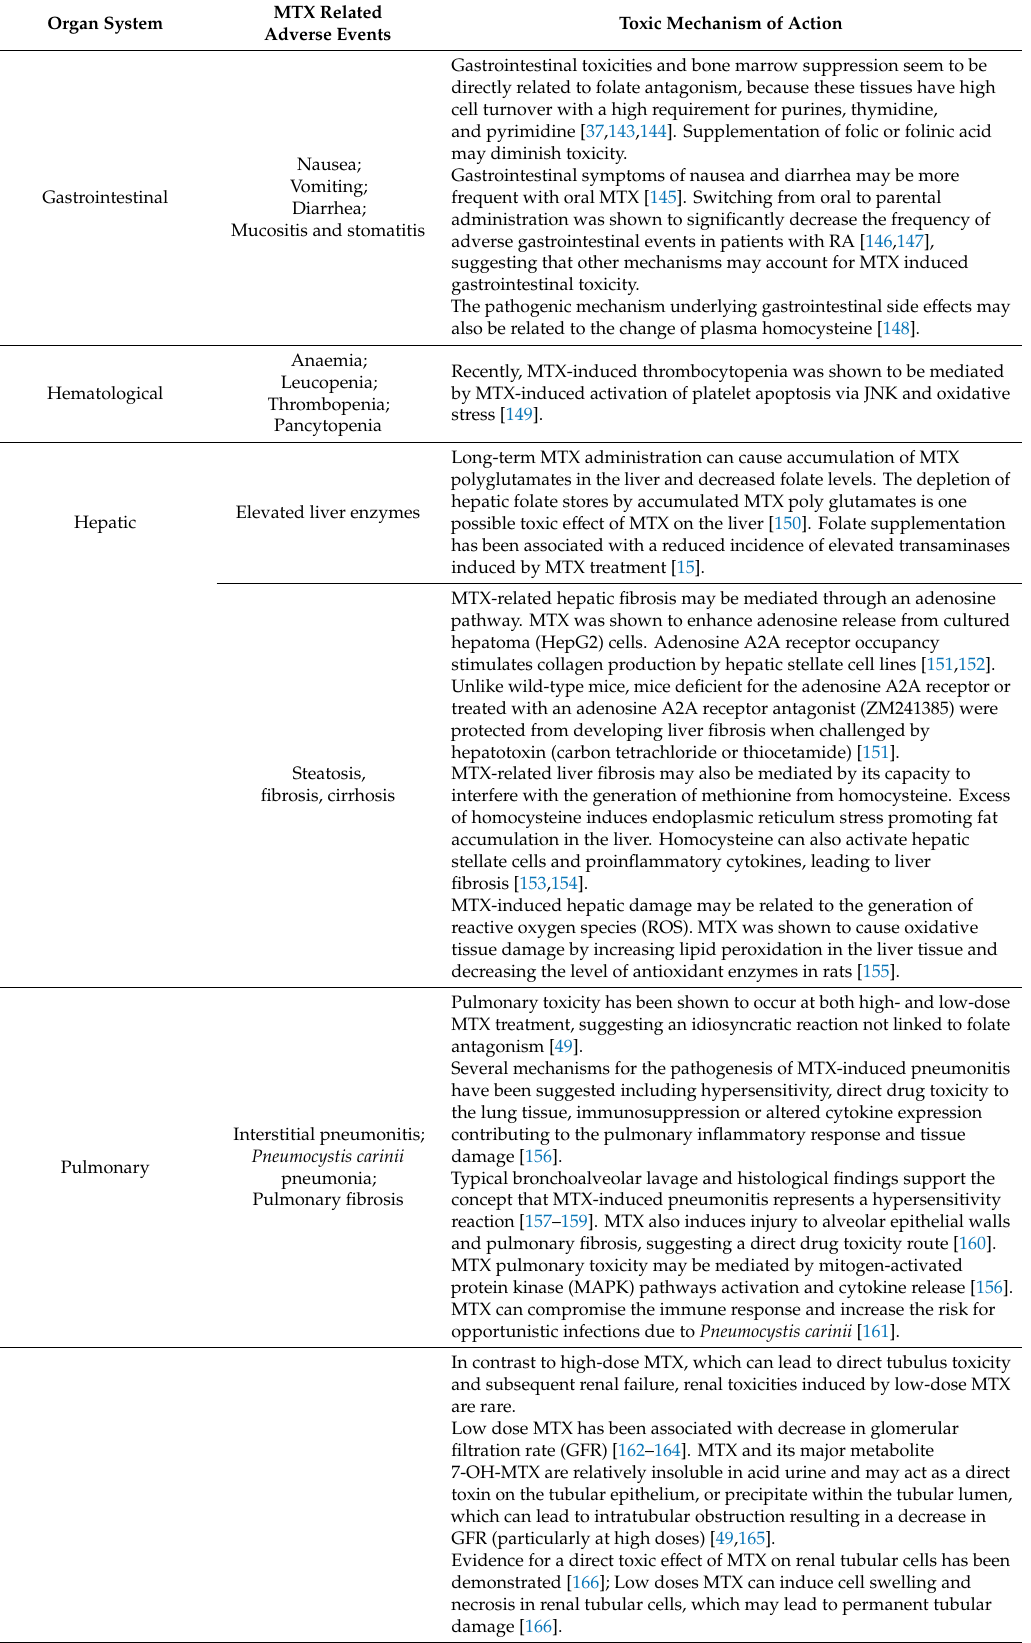
Table 1. Major low dose MTX related adverse